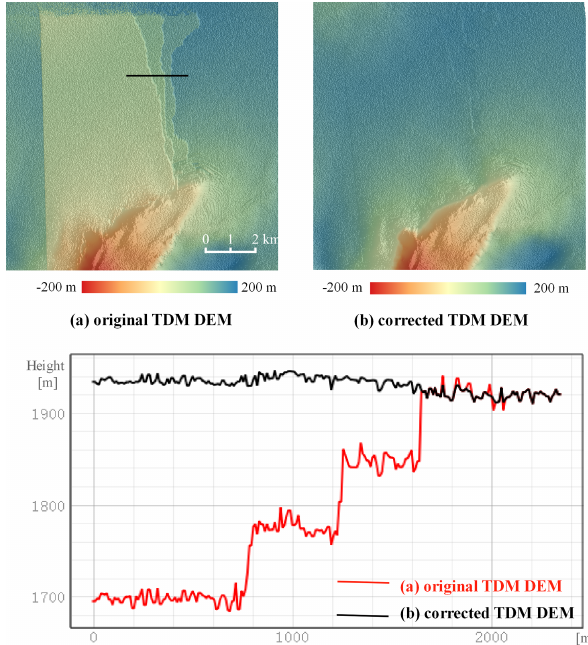
termined from the intermediate correction results. In the fol- lowing we explain in detail the process of multi-scale correc- tion for the local and HG experimental areas. In the elevation difference maps of typical regions with PU errors such as in Figs. 11a and 12a, the elevation discrepancies have abso- lute values larger than 50 m. Then at the first correction, we set the threshold as 45 m to separate the background pixels. After this first iteration the remaining elevation discrepan- cies reduce to absolute errors larger than 20 m as visible in Figs. 11b and 12b. After applying the second correction (with a 20 m threshold), residual elevation offsets are still visible in the elevation difference maps (Figs. 11c and 12c). Therefore we set 5 m as the threshold for the small-scale